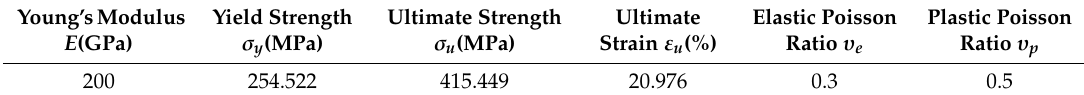
Table 1. Relevant mechanical parameters.